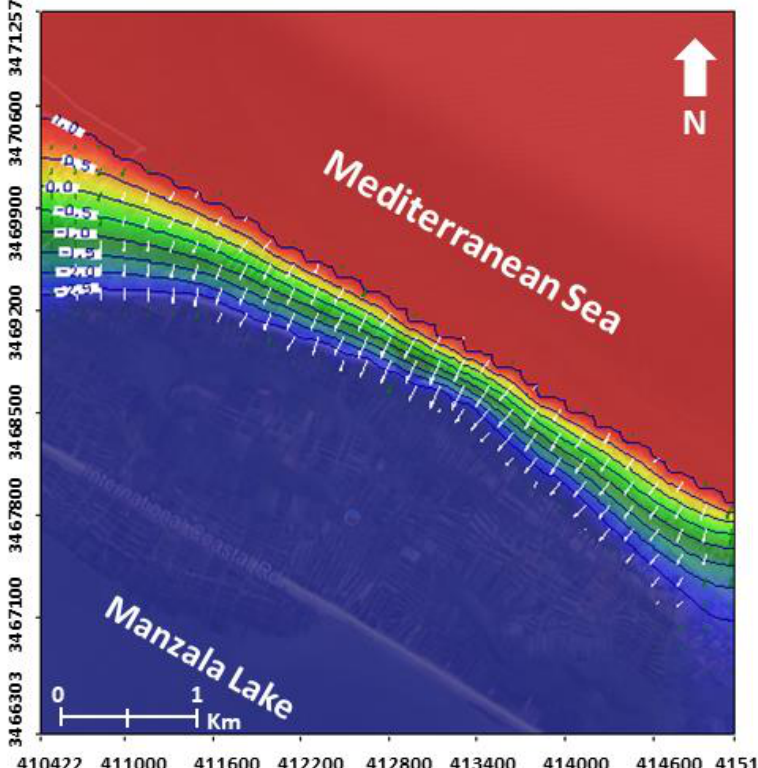
Figure 9. Calculated groundwater levels in 2018.